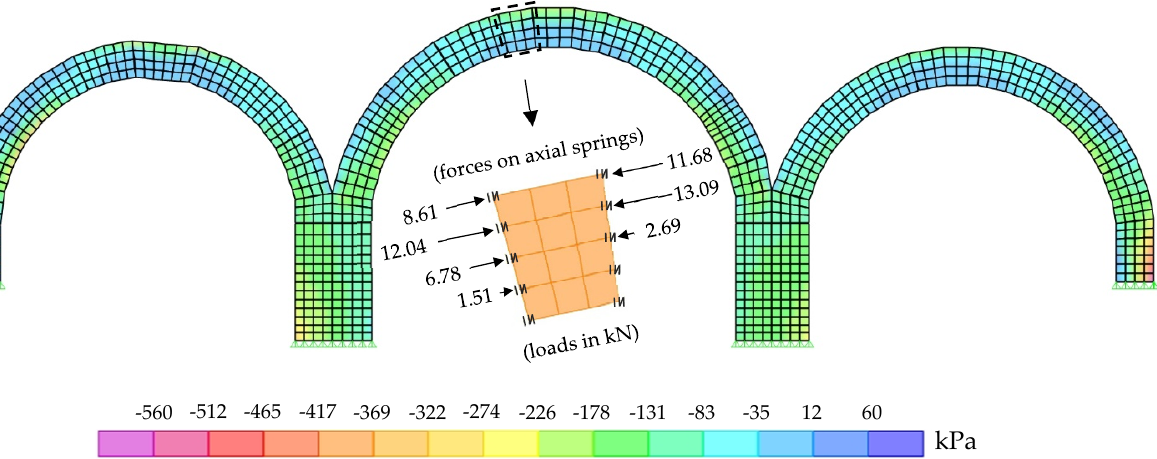
Figure 12. Dead load analysis results for the existing bridge (backfill excluded from the figure).